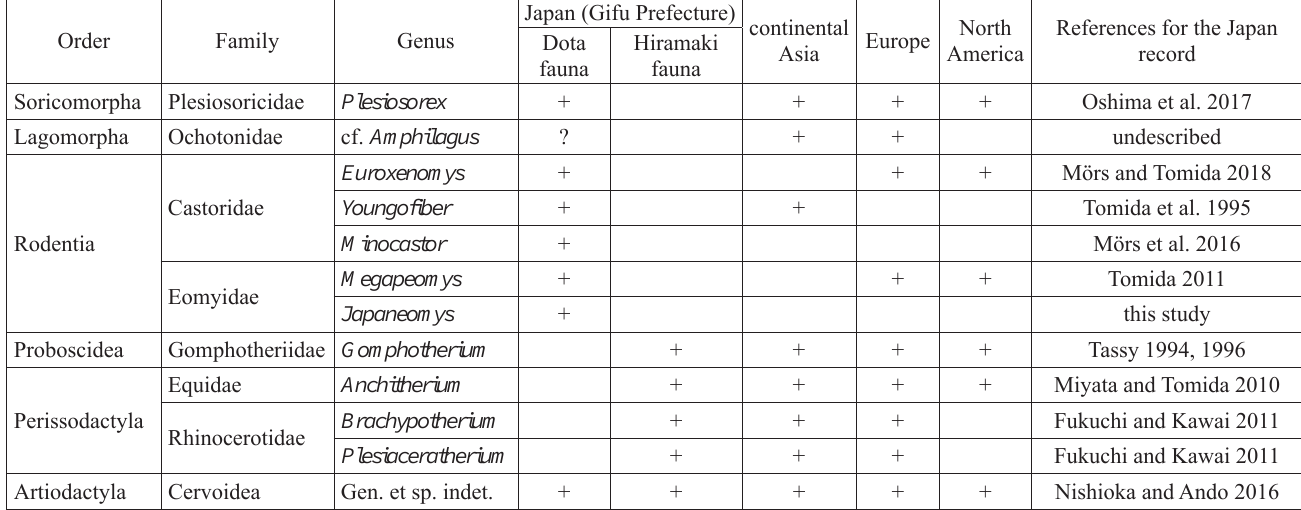
Table 1. Continental-scale geographic distribution of mammals of the Dota and Hiramaki faunas at the generic level.